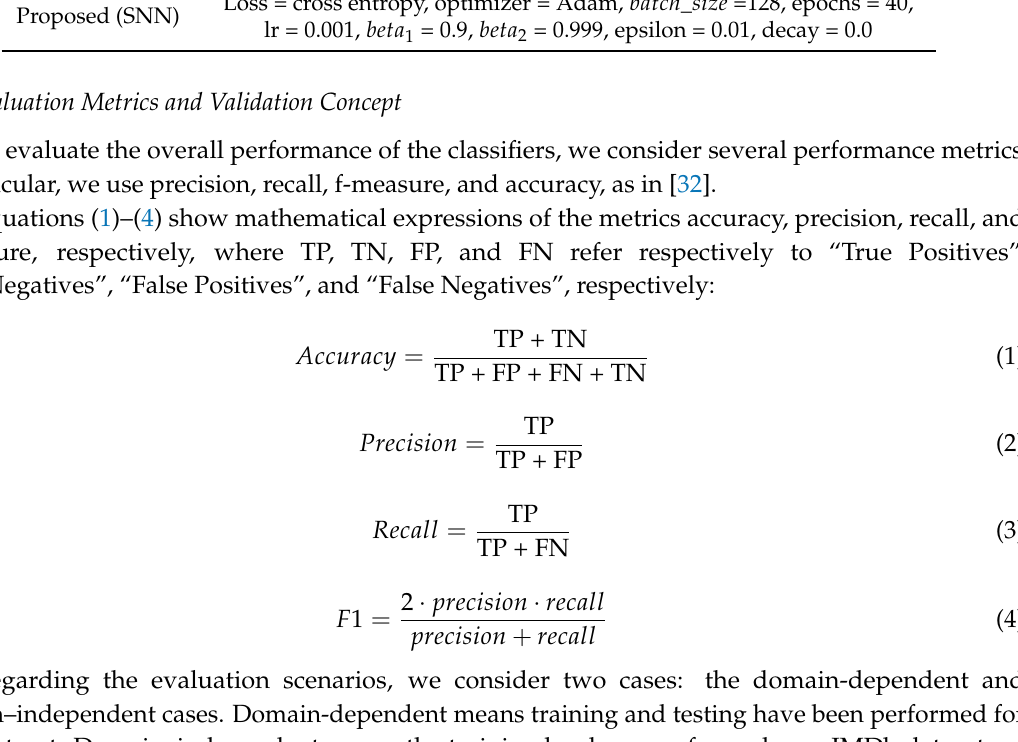
Table 4. Values of parameters of proposed CNN, SNN, and other classifiers. Model Parameters SVM (poly) Degree of the polynomial kernel function = 3, γ = 1 numberof features γ = 1 numberof features Number of estimators estimators =10 trees, criterion = Gini impurity, Random Forest The minimum number of samples required to split an internal node = 2 Naive Bayes Prior = probabilities of the